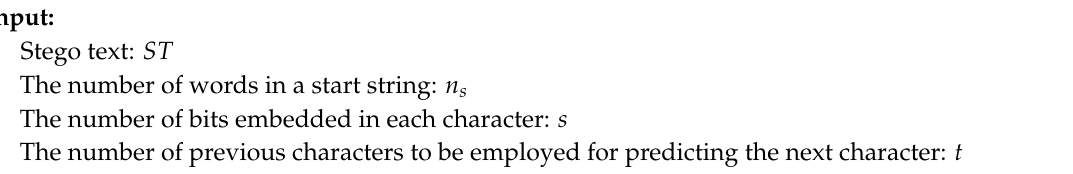
Algorithm 2 Information extraction